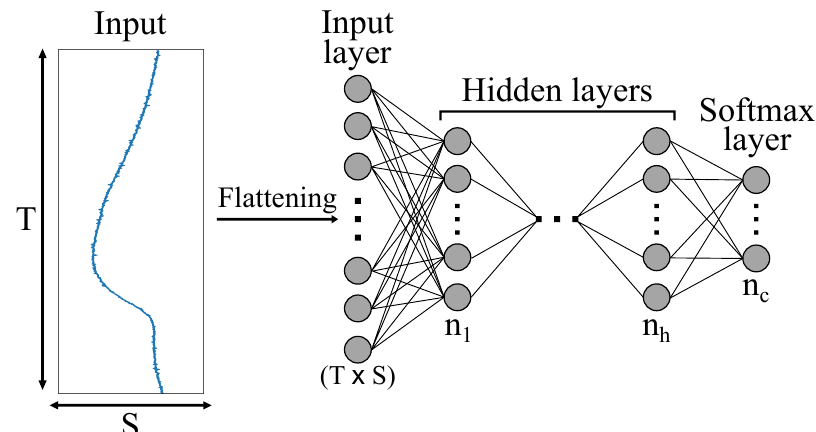
Figure 7. Schematic illustration of an Multi-Layer Perceptron (MLP) architecture with h hidden layers and c output classes presented by a softmax layer. Initially, the different sensor channels are flattened into a ( T × S )-dimensional vector and then fed to the various hidden layers.